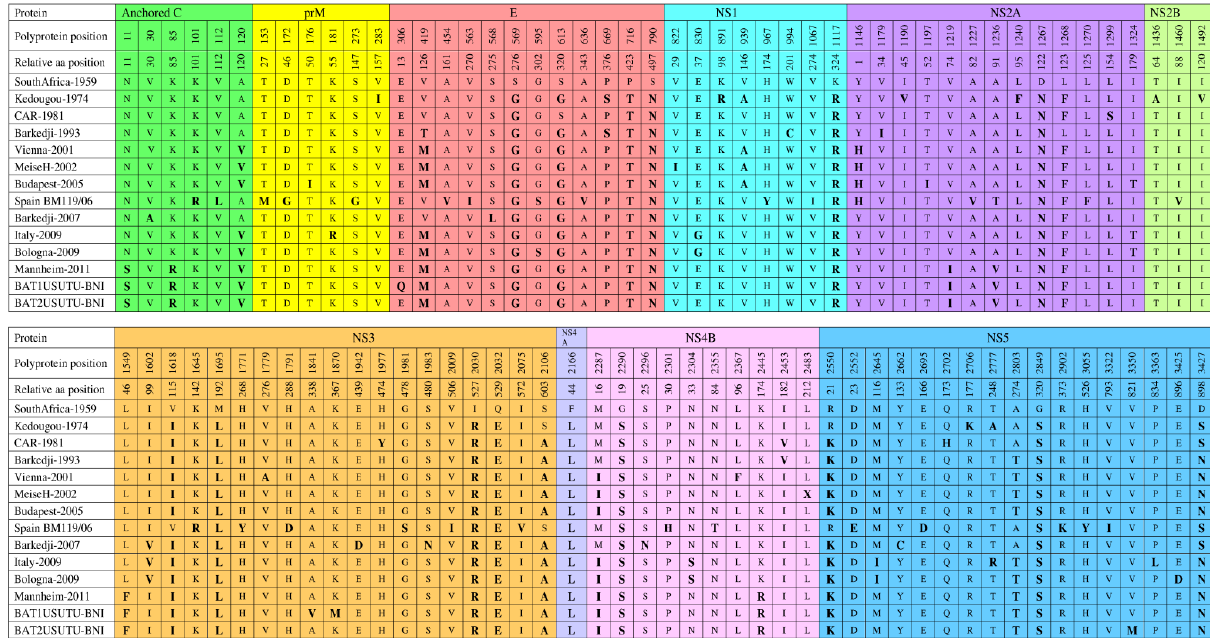
Figure 4. Comparison of polyprotein precursors of fully sequenced USUV strains.